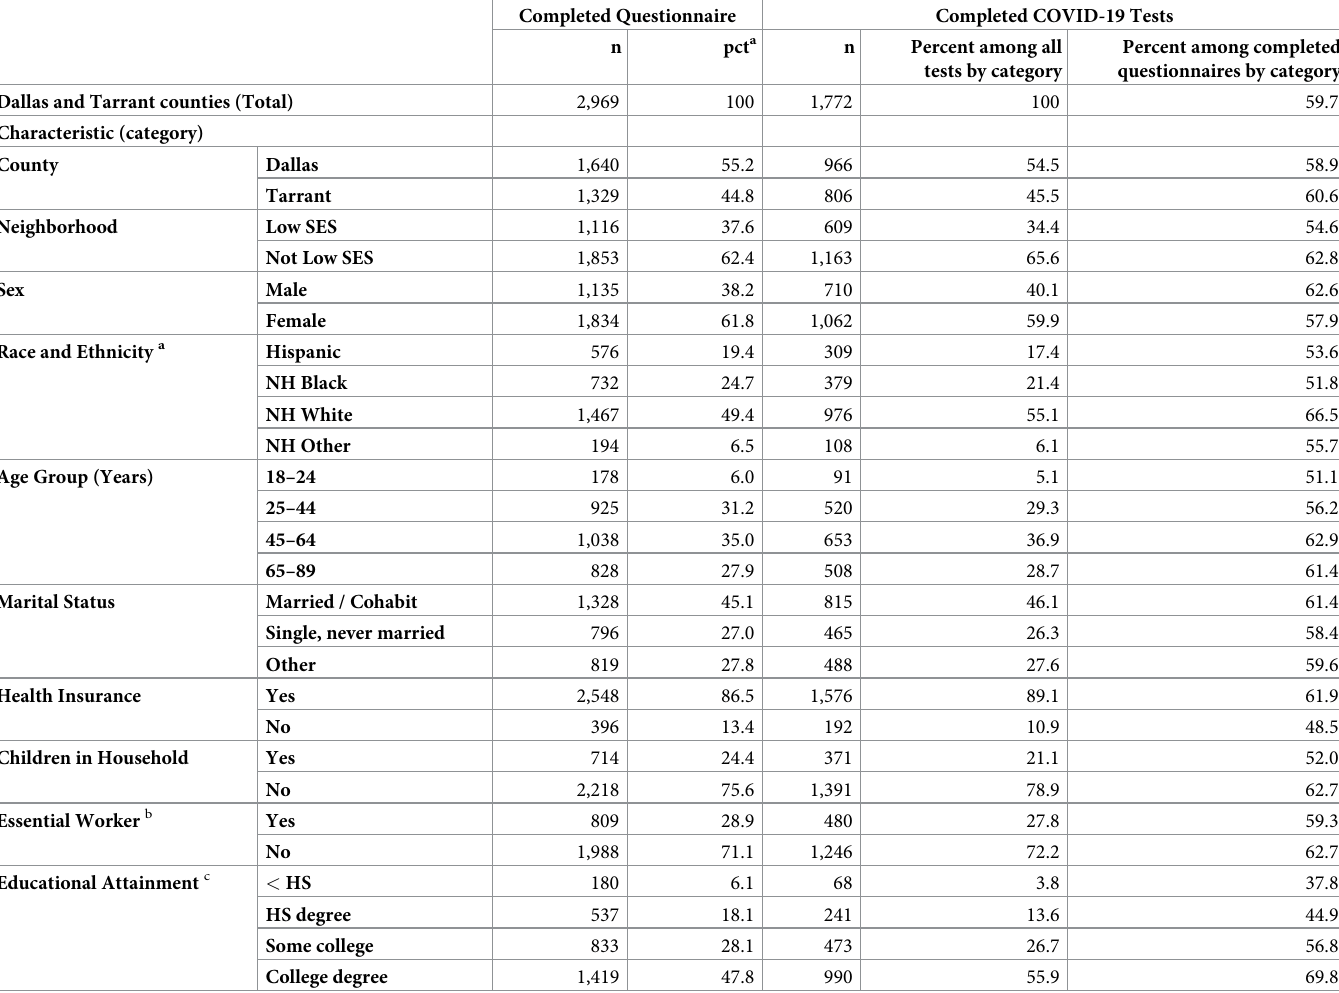
Table 1. Distribution of participants by select